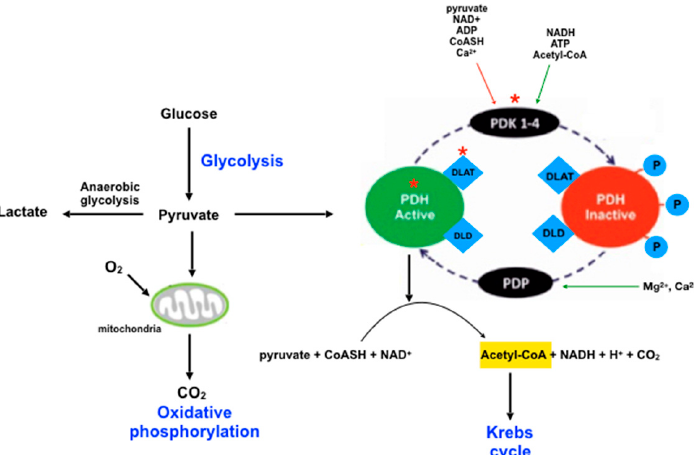
Figure 5. Schematic representation of the main altered metabolic pathways in MTLE revealed by proteomic analysis: glycolysis, pyruvate metabolism, Krebs cycle and oxidative phosphorylation. The affected proteins pyruvate dehydrogenase (PDH), PDH kinases (PDK) and dihydrolipoamide S-acetyltransferase (DLAT) are indicated by red asterisk.